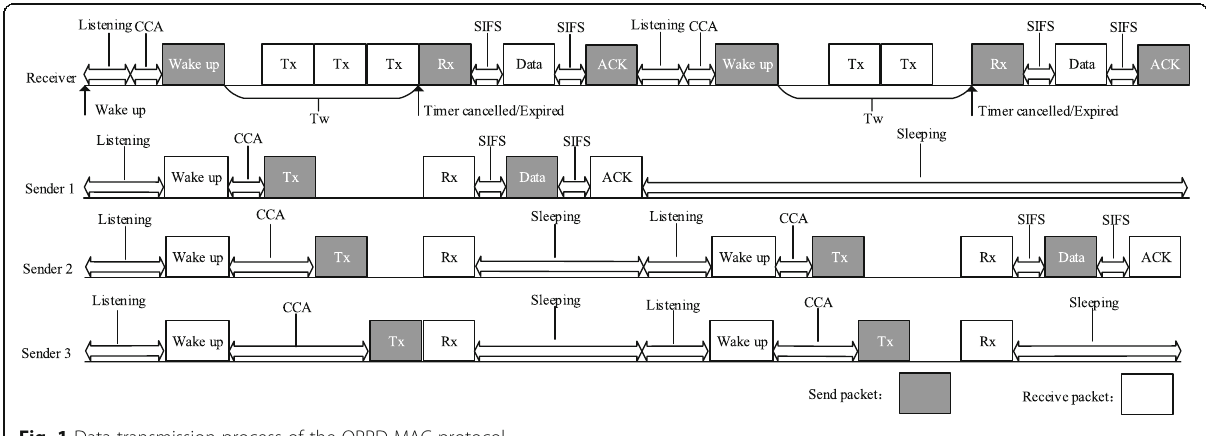
Fig. 1 Data transmission process of the QPPD-MAC